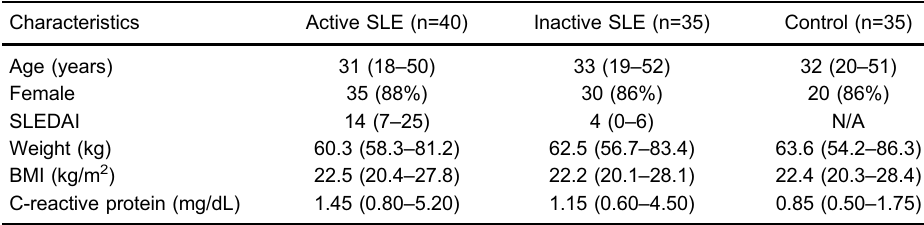
Table 1. Baseline demographic and clinical characteristics of patients with systemic lupus erythematosus (SLE) and controls.